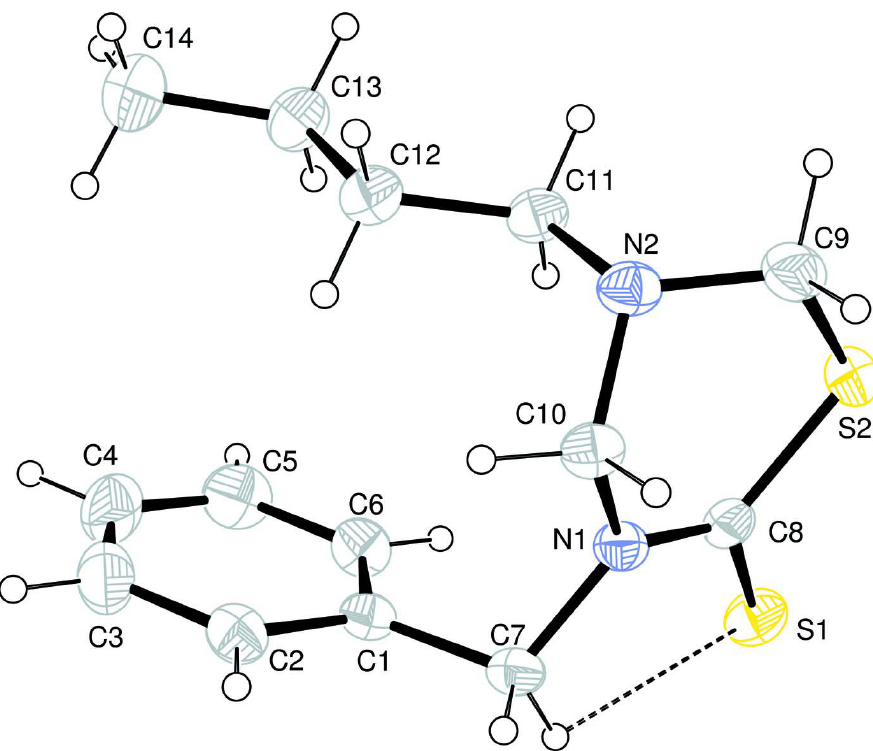
Figure 1 ORTEP drawing of the title compound, with the atom numbering scheme. The thermal ellipsoids are drawn at the 30% probability level. H-atoms are shown by small circles of arbitrary radii. The intramolecular H-bonding is shown by dotted